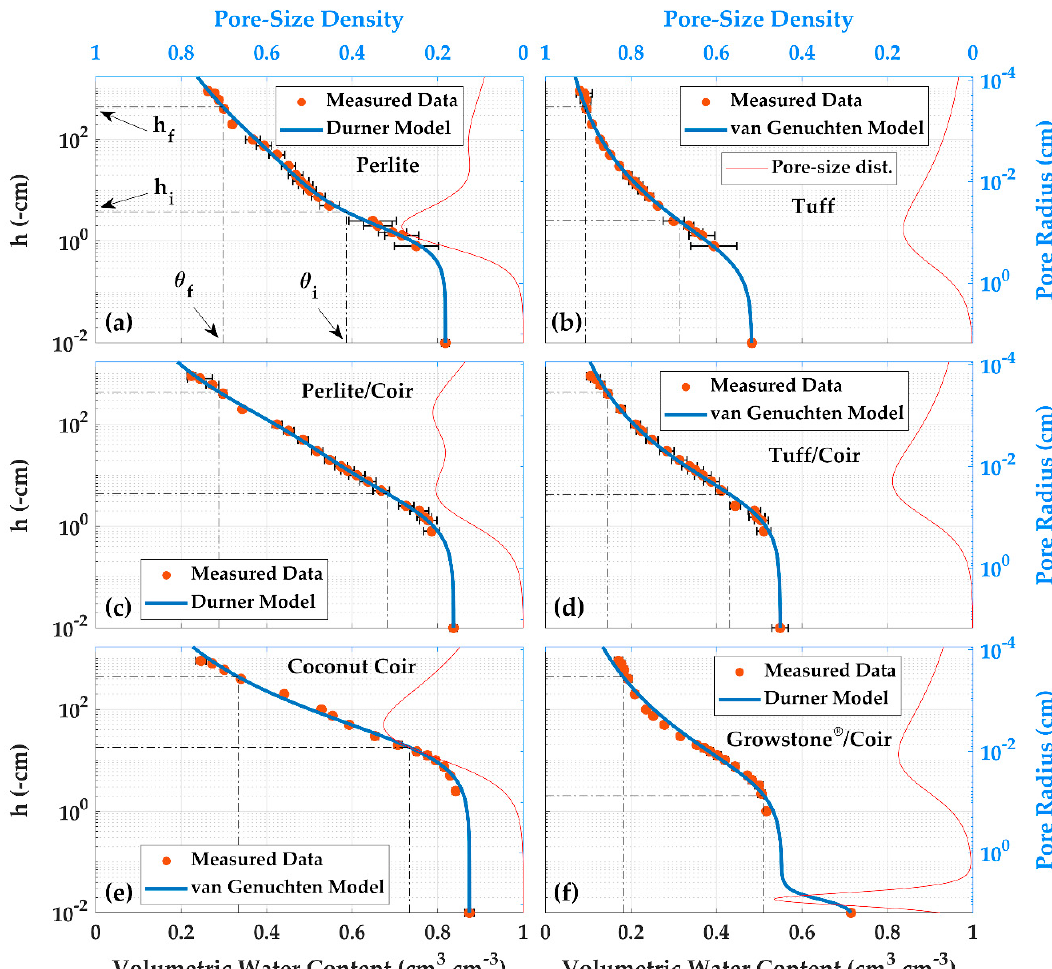
Figure 4. Measured WC data displayed with the fitted unimodal van Genuchten (Equation (6)) or bimodal Durner (Equation (7)) WC models for: ( a ) perlite, ( b ) tuff, ( c ) perlite/coconut coir, ( d ) tuff/coconut coir, ( e ) coconut coir, and ( f ) Growstone ® /coconut coir. The error bars represent the standard deviation of the measured volumetric water contents. The wet- and dry-end matric potential thresholds, h i and h f , and their corresponding water contents, θ i and θ f , are marked with dash-dotted lines. The pore size distributions associated with the WC curves are plotted on the right side.